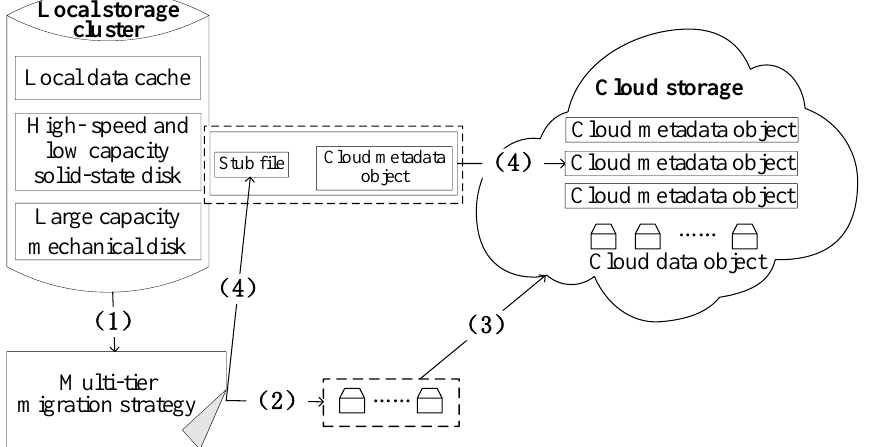
Figure 2. Diagram of data archive operation